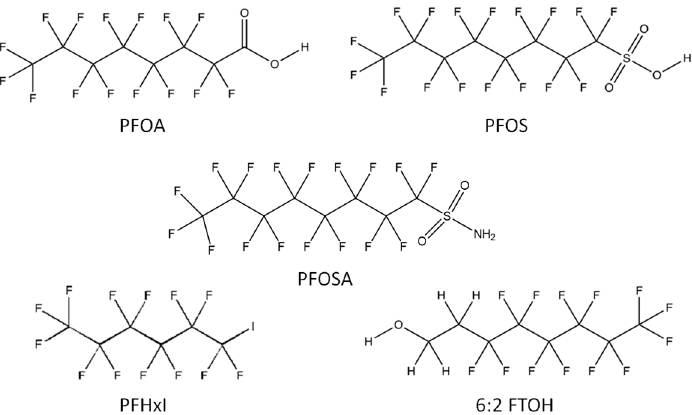
Figure 2. Chemical structure of some